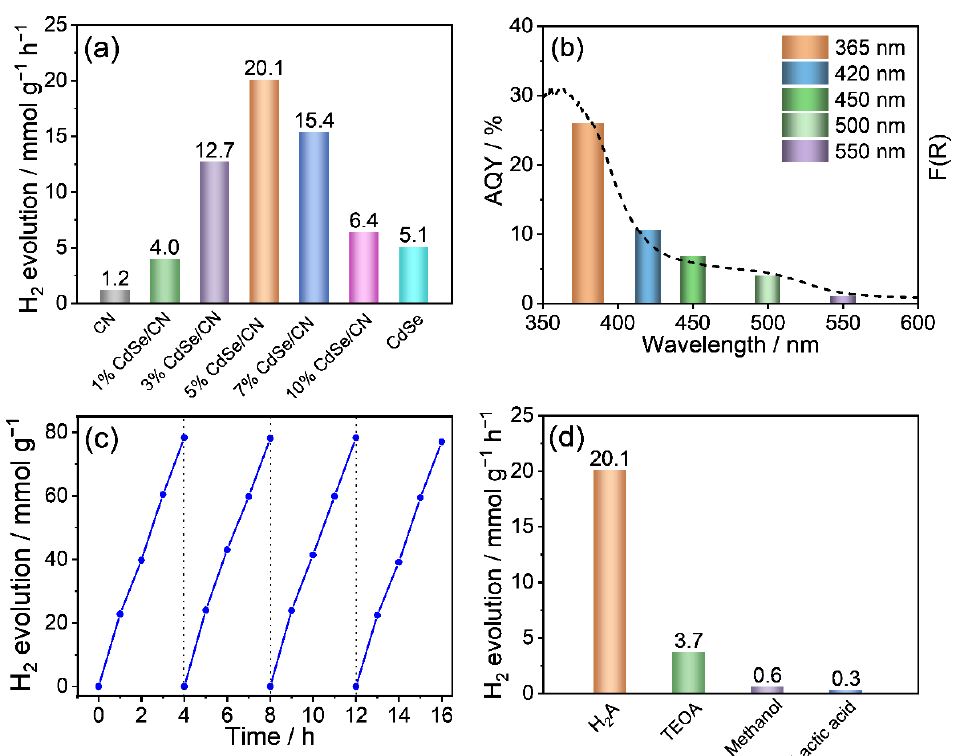
Figure 6. ( a ) Photocatalytic hydrogen evolution rates over CdSe/CN photocatalysts with different CdSe loading amount using ascorbic acid (H 2 A) as sacrificial reagent at pH 4.0. ( b ) Hydrogen evolution rates evolved from 5% CdSe/CN by changing sacrificial reagent. ( c ) Wavelength-dependent hydrogen evolution rates of 5% CdSe/CN. ( d ) Time-dependent photocatalytic hydrogen evolution rates over 5% CdSe/ CN.